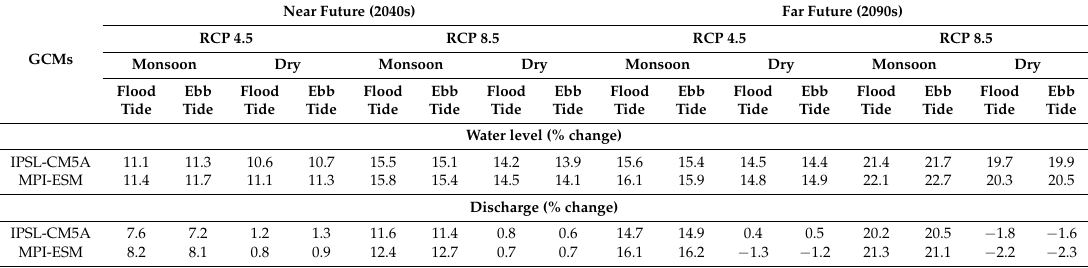
Table 3. Projected change (%) in seasonal mean water level and discharge at Noapara in the Betna River: Comparison of the two Representative Concentration Pathway (RCP) scenarios for the near (2040s) and far (2090s) future with the baseline year. The monsoon season occurs during June–September and the dry season during